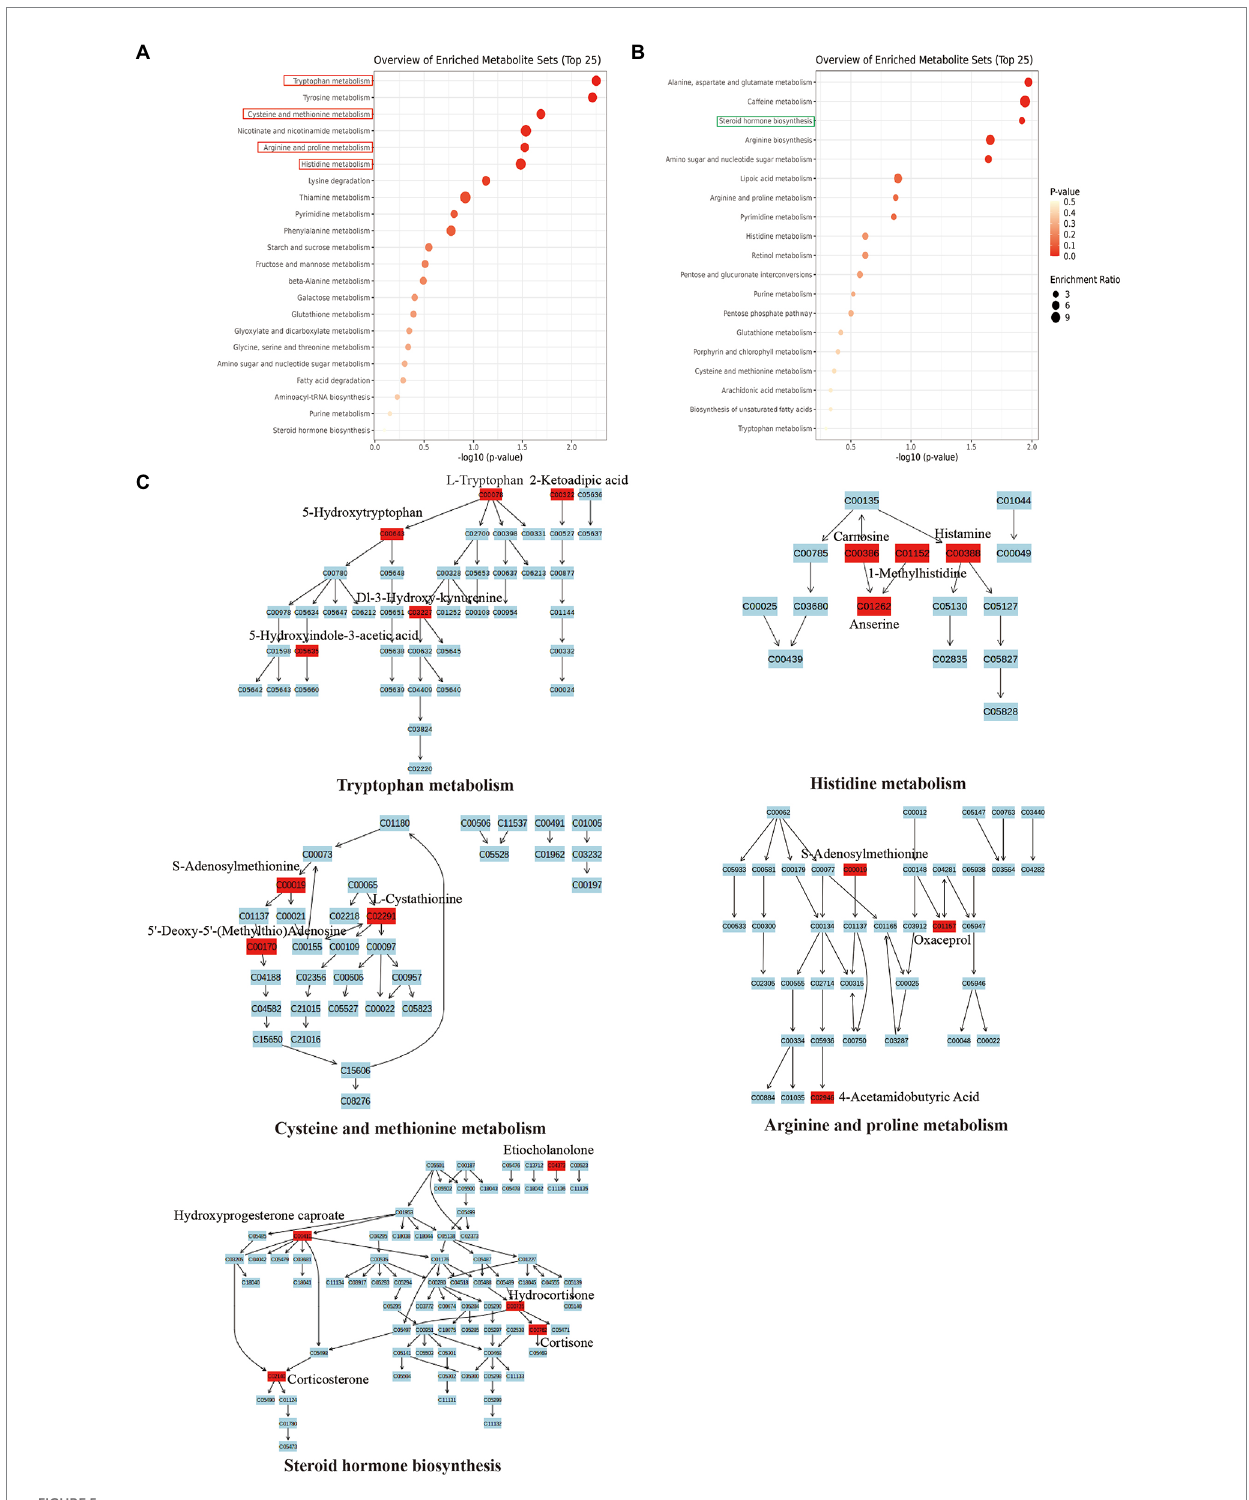
FIGURE 5 Major metabolic pathway involved in the differentially enriched metabolites of SMG mice compared to controls. (A) The major metabolic pathways involved in increased metabolites. (B) The major metabolic pathways involved in decreased metabolites. (C) Reaction steps for 5 major metabolic pathways both involved in increased and decreased